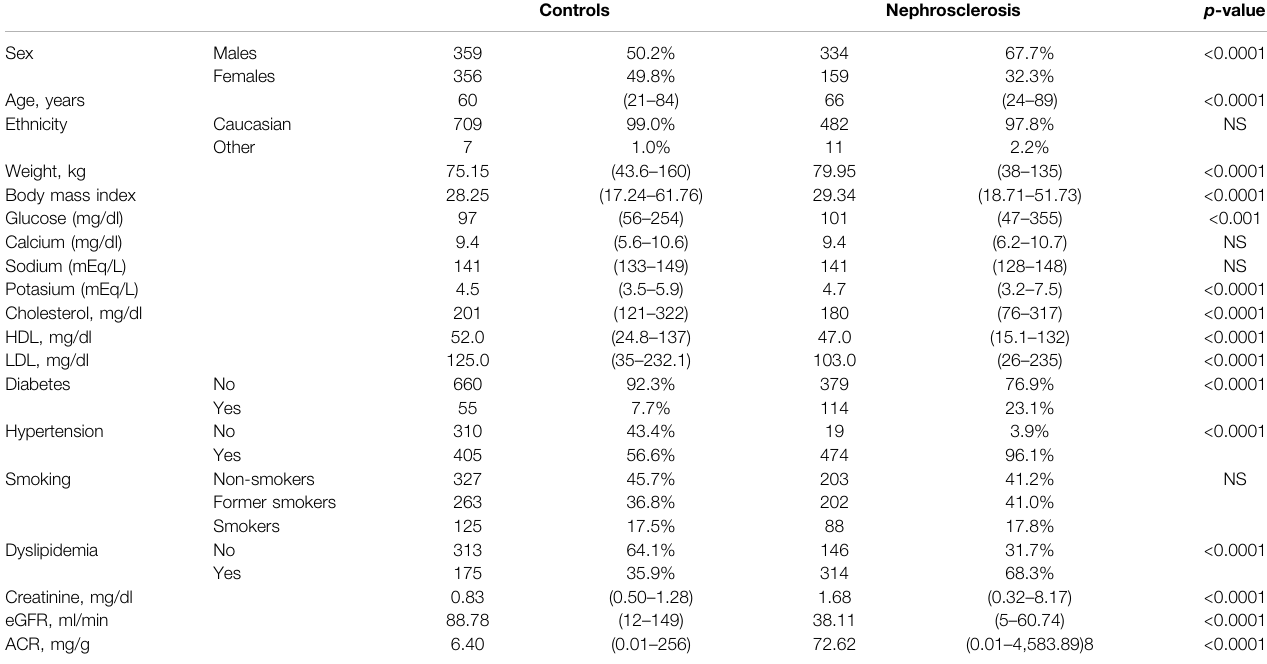
TABLE 1 | Demographic, biochemical, and clinical characteristics of the population of study. Median (range) or count (percentage) is shown. Controls